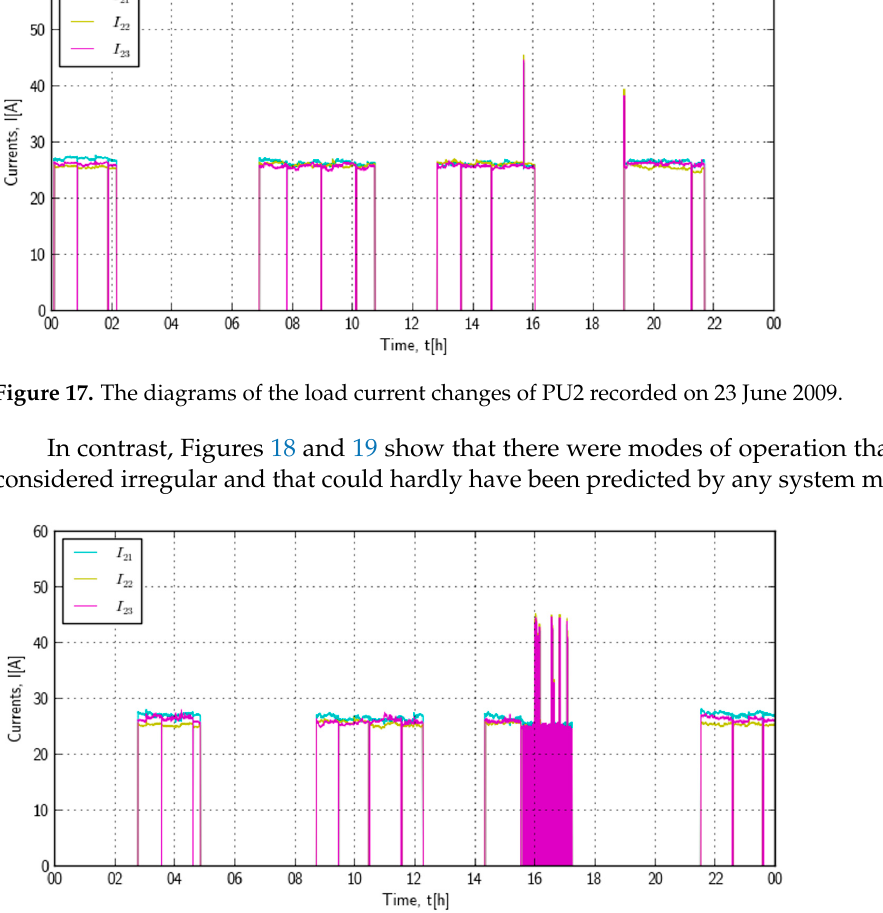
Figure 16. The diagrams of the load current changes in PU1 recorded on 27 June 2009.